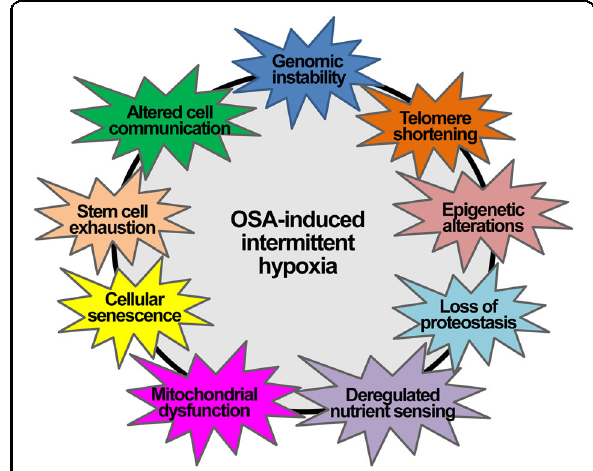
Fig. 8 The hypothetical impact of OSA-induced intermittent hypoxia on aging and aging-related diseases. OSA-associated intermittent hypoxia may promote the induction of the nine hallmarks of aging: genomic instability, telomere shortening, epigenetic alterations, loss of proteostasis, deregulated nutrient sensing, mitochondrial dysfunction, cellular senescence, stem cell exhaustion, and altered intercellular communication. These changes accelerate aging and aging-related diseases, such as